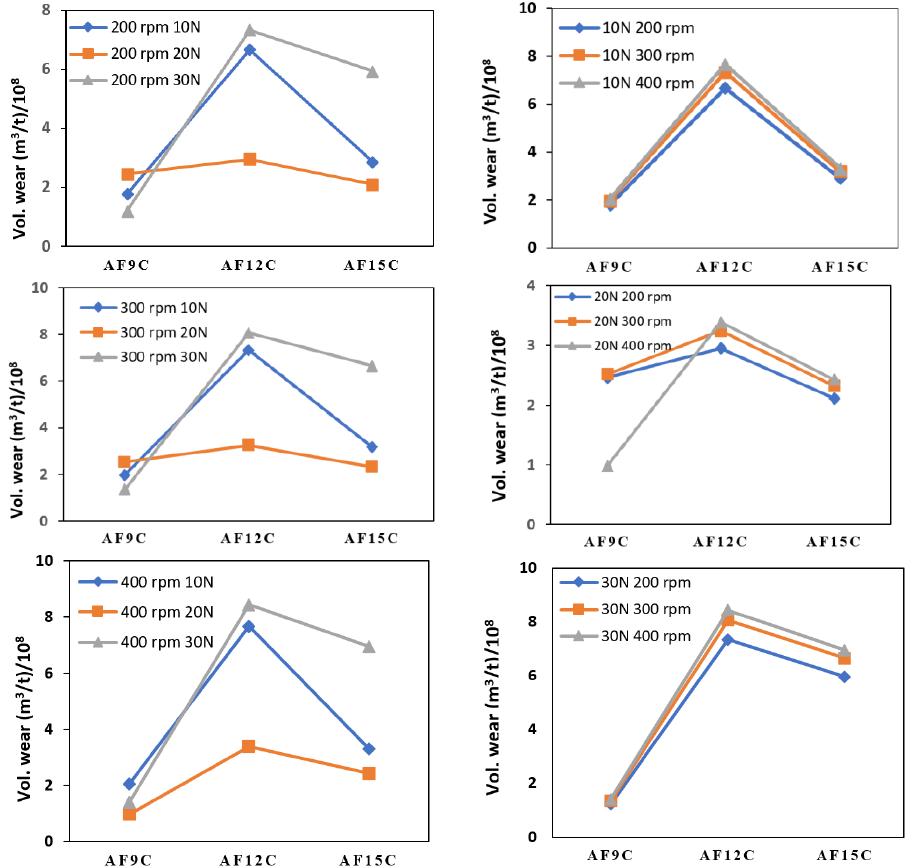
Figure 13. Effect of Disc RPM and Load Variation on volumetric wear of the composite specimen.